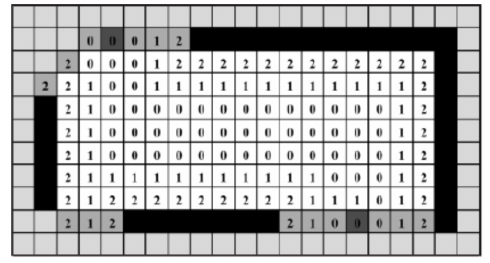
Figure 3. Obstacles transform.